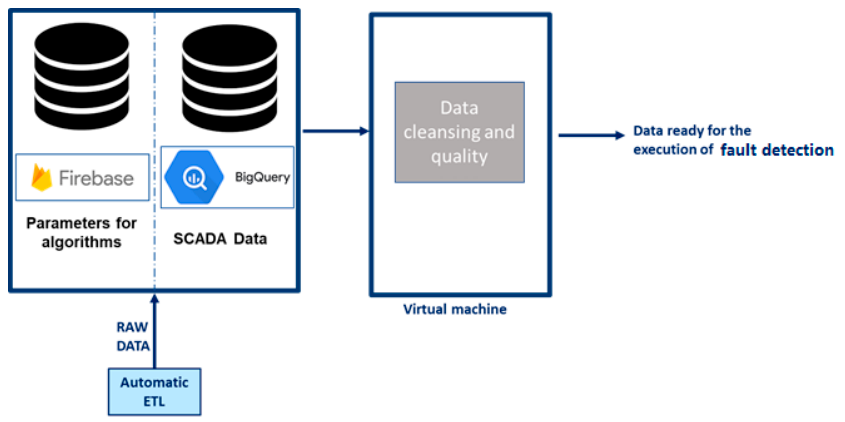
Figure 4. Data process for extracting/acquiring raw data using an ETL method and preparing them for the data quality analysis and execution of fault detection algorithms.